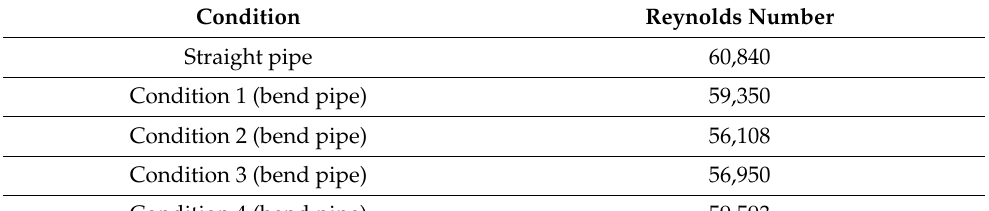
Figure 3. Schematic diagram of starting the wheeled capsule at different positions of the bend pipe.